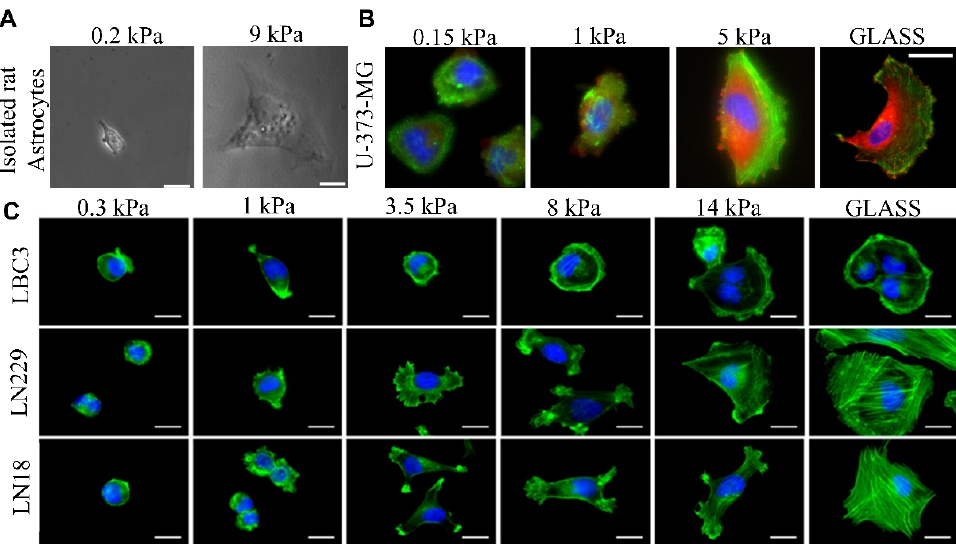
Figure 7. Gel stiffness influence on cells spread area. Phase images of isolated astrocytes on soft and stiff polyacrylamide gels ( A ). Human glioblastoma cells U-373-MG on hyaluronic acid hydrogels of various stiffness ( B ). Isolated human glioblastoma cells LN18, LN229 and LBC3 on various polyacrylamide gels ( C ). Scale bars: A, B—50 µm; C—15 µm. Figure adapted with permission from Refs. A— [219]. 2006, Georges P.C. ; B— [220]. 2011, Ananthanarayanan B.; C—[17]. 2017, Pogoda K.